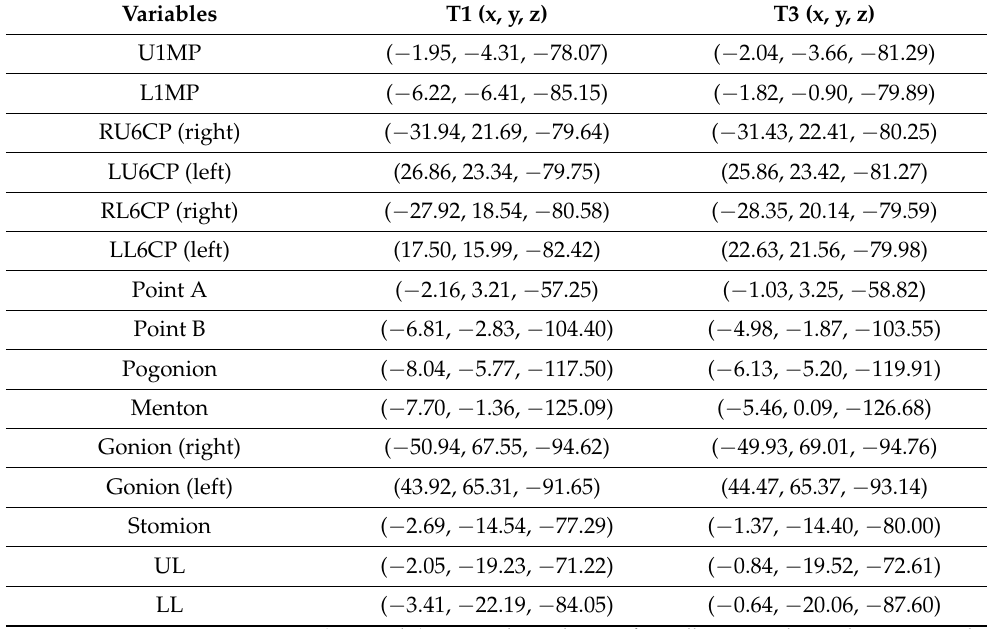
Figure 4. Pretreatment CBCT images using 3-dimensional coordinates. ( A ) Frontal image; ( B ) Sub- mentovertex image (arrow means mandibular yawing); ( C ) Sagittal image (right side); ( D ) Sagittal image (left side). Table 2. Three-dimensional cephalometric measurements.